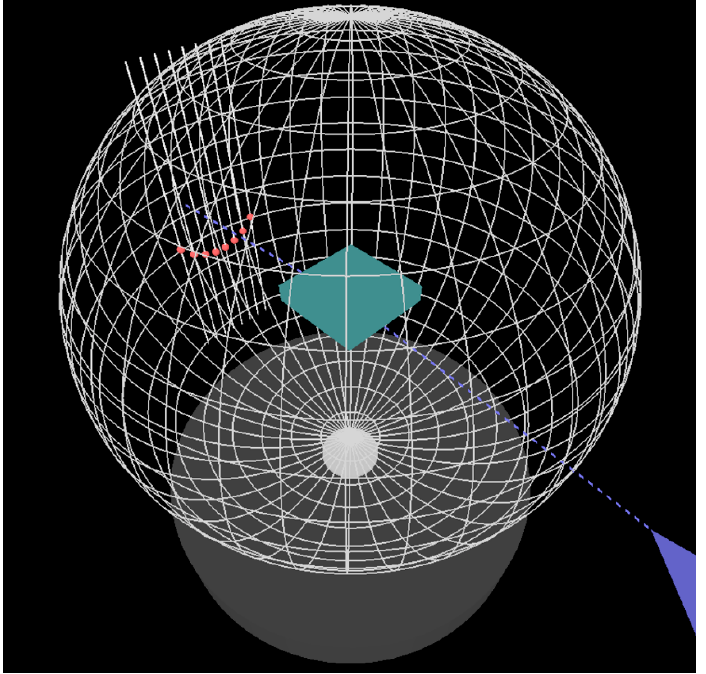
Figure 4. A skew view from a virtual camera that can be moved continuously to different observation points by a user of the application.